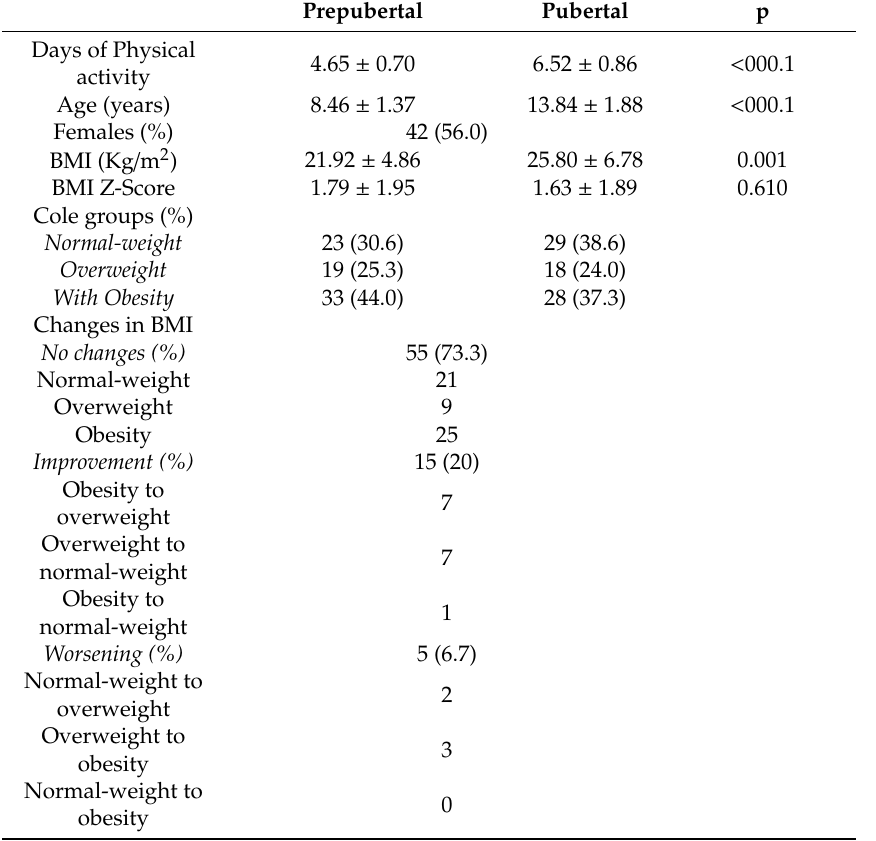
Table 1. Characteristics of the longitudinal sample (n = 75) at prepubertal and pubertal periods and evolution in weight